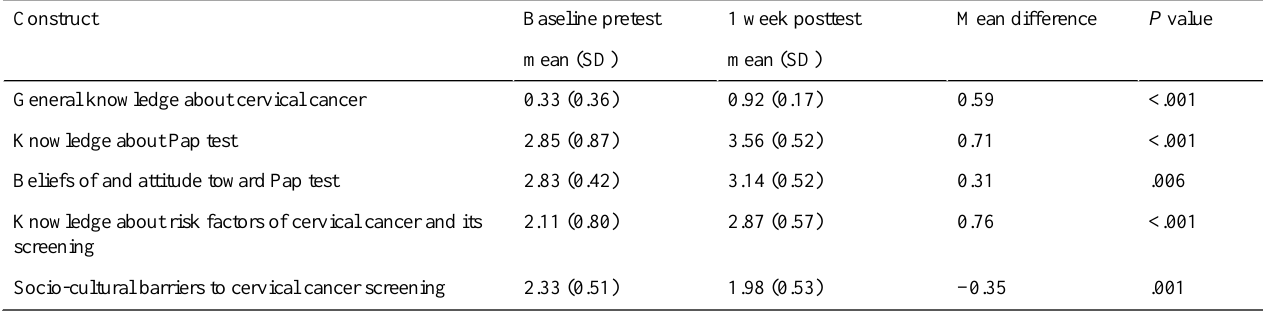
Table 2. Changes in knowledge, attitudes, and beliefs about cervical cancer and the Pap test (N=30).